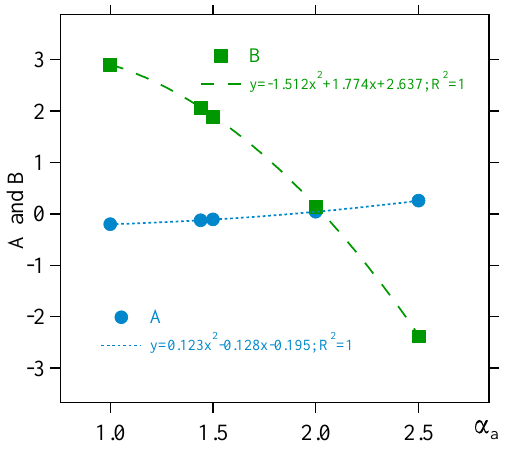
Figure 1. Double logarithmic plot of C versus λ for α a = 1 (or- ange), 1.5 (green), 2 (blue), and 2.5 (violet), respectively.